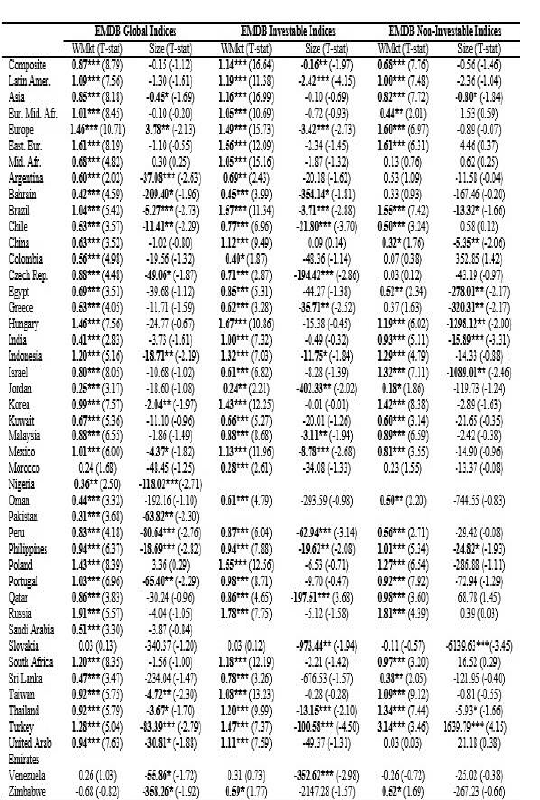
Table 5: Size Effects, Time Series Regressions (EMDB